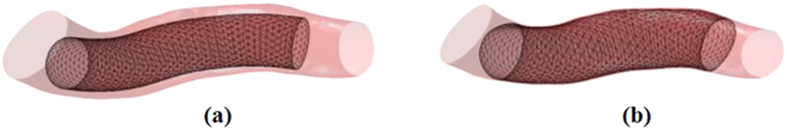
The stent contour before and after the expansion.(a) Initial stent contour. (b) Final stent contour satisfying the termination conditions.